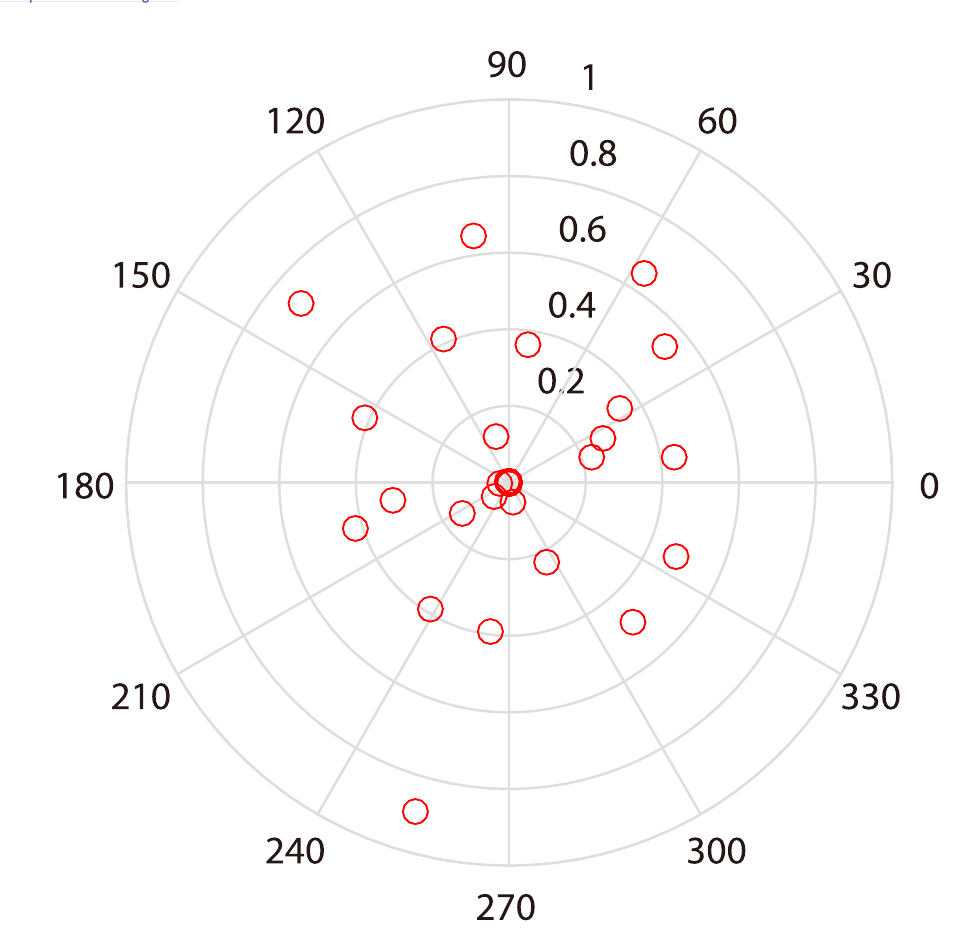
Fig 6. The spectral radiuses for 42 estimated bivariate marked Hawkes processes. It can be seen that all 42 Hawkes processes are stationary.